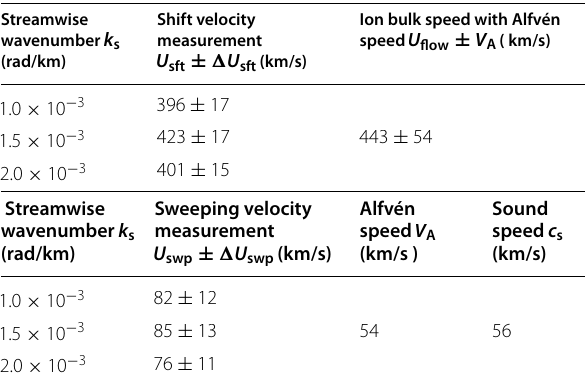
Table 1 Measured shift velocity and sweeping velocity in comparison to the theoretical estimate for the ion bulk speed, Alfvén speed, and sound speed using the mean val- ues of plasma and magnetic field